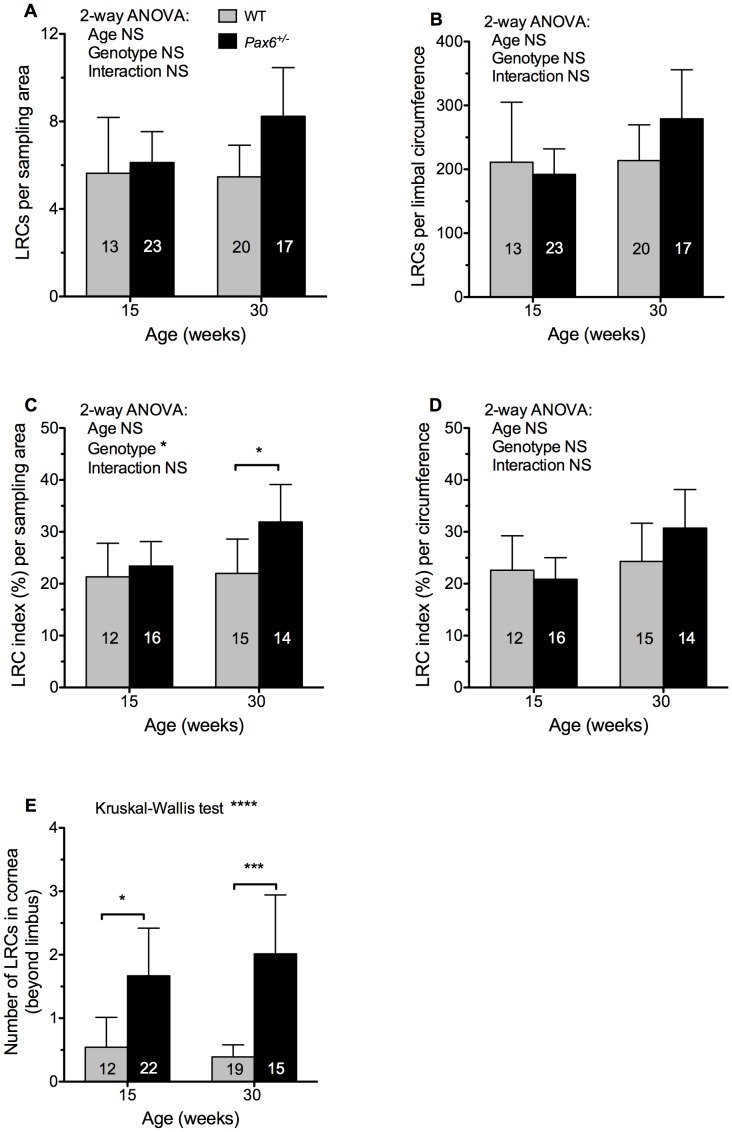
Comparison of label-retaining cell numbers between WT and Pax6+/− limbal and corneal epithelia.(A) Label-retaining cells (LRCs) per 340×200 µm sampling area. (B) LRCs per 200 µm wide ring around the limbal circumference. (C) LRC index per sampling area. (D) LRC index per limbal circumference. See text for explanation of LRC index. (E) LRCs that were within the cornea rather than the limbal area (more central than the sampling box shown in Fig. 6B). Results were compared by 2-way ANOVA followed by Bonferroni post-hoc tests (A–D) or Kruskal-Wallis test followed by Dunn’s multiple comparison test (E). Significant pairwise differences for genotypes or ages are shown by asterisks: *P<0.05, ***P<0.001, ****P<0.0001, NS, not significant. Error bars are 95% confidence intervals. The number of eyes per group is shown within each bar.